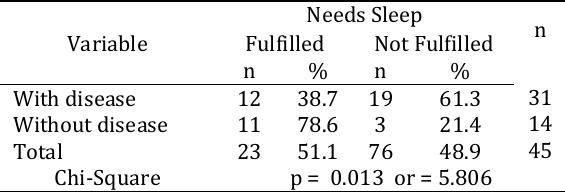
Table 1. The Results of the Analysis of the Relationship Between Elderly Sleep Needs and